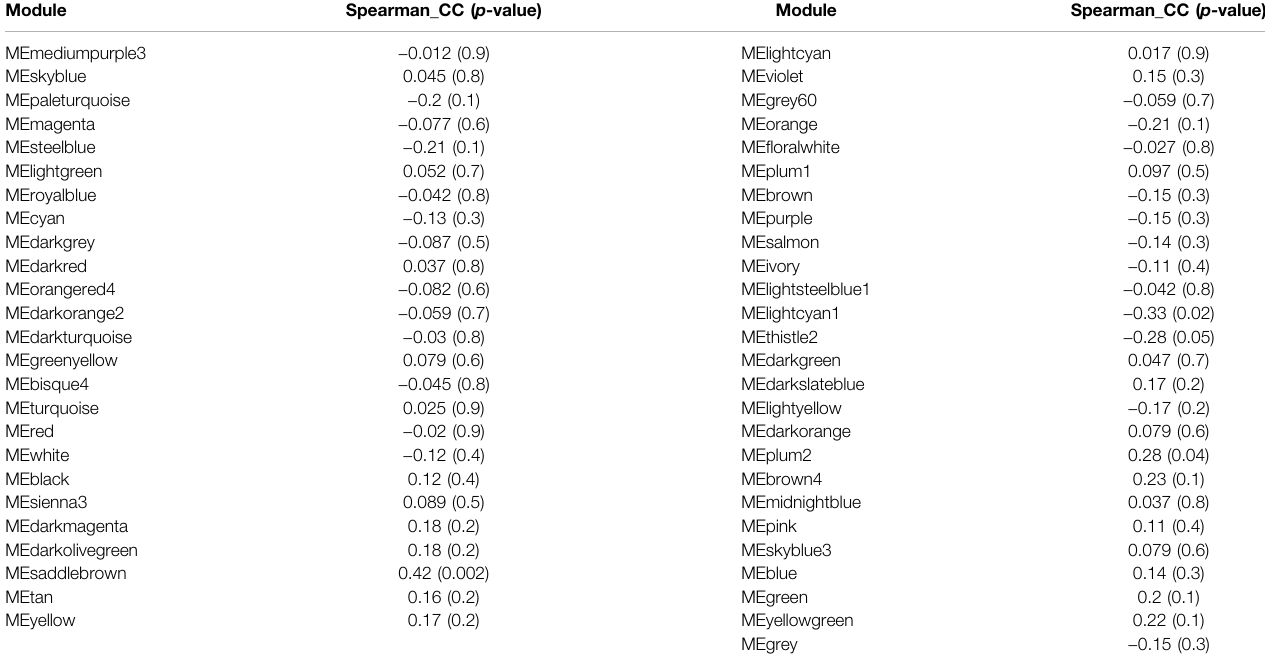
TABLE 1 | Two candidate modules speculated the critical role for the pathophysiology of MD.